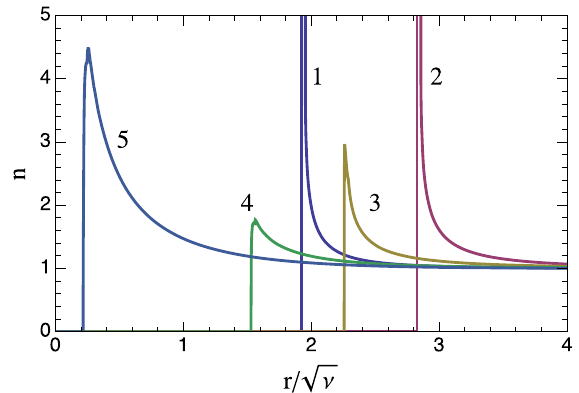
FIG. 4. Electron density distributions in radial direction for various values of ξ : (1) ξ ¼ 0 . 5 , (2) ξ ¼ ξ m ¼ 1 . 57 , (3) ξ ¼ 2 . 5 , (4) ξ ¼ 3 , (5) ξ ¼ 3 . 7 .